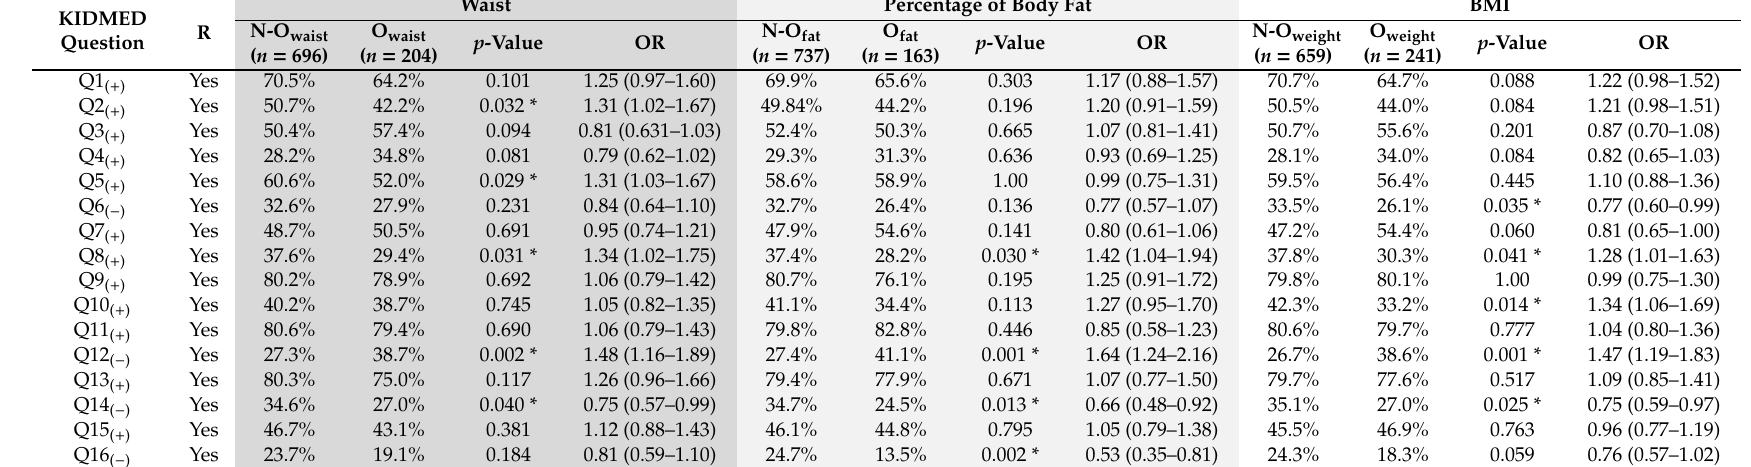
Table 3. Responses in the KIDMED questionnaire in over and non-over boys according to selected body composition